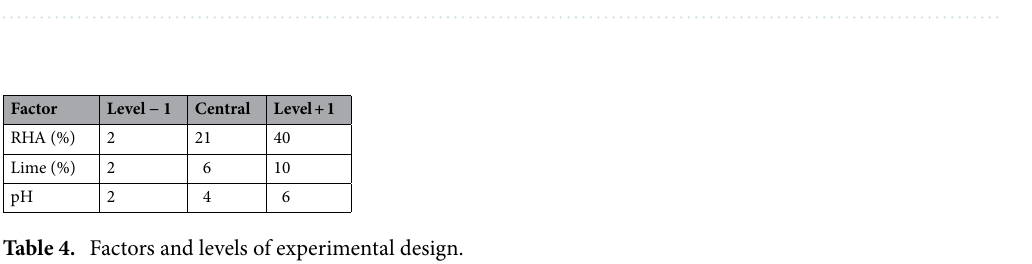
Table 3. Chemical composition of the leached and solubilized extract and respective limits according to NBR 10004 28 .